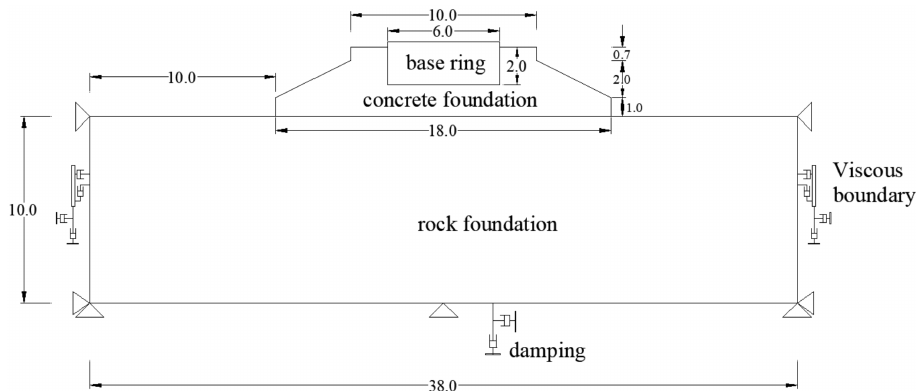
Figure 6. Sketch of calculation and boundary (Unit: m).